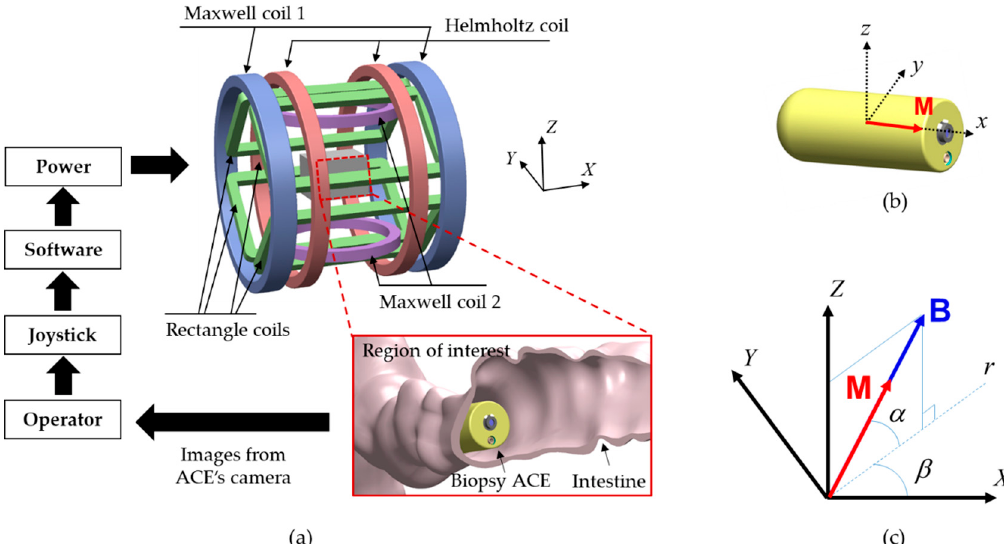
Figure 4. ( a ) Magnetic locomotion system. ( b ) Local coordinate of the CE robot; M represents the magnetization vector of the capsule. ( c ) Alignment of the capsule in the world coordinate system; B represents the controlled magnetic field, α represents the aligned angle between B and the XY plane, and β represents the aligned angle between the Zr plane and the XZ plane.